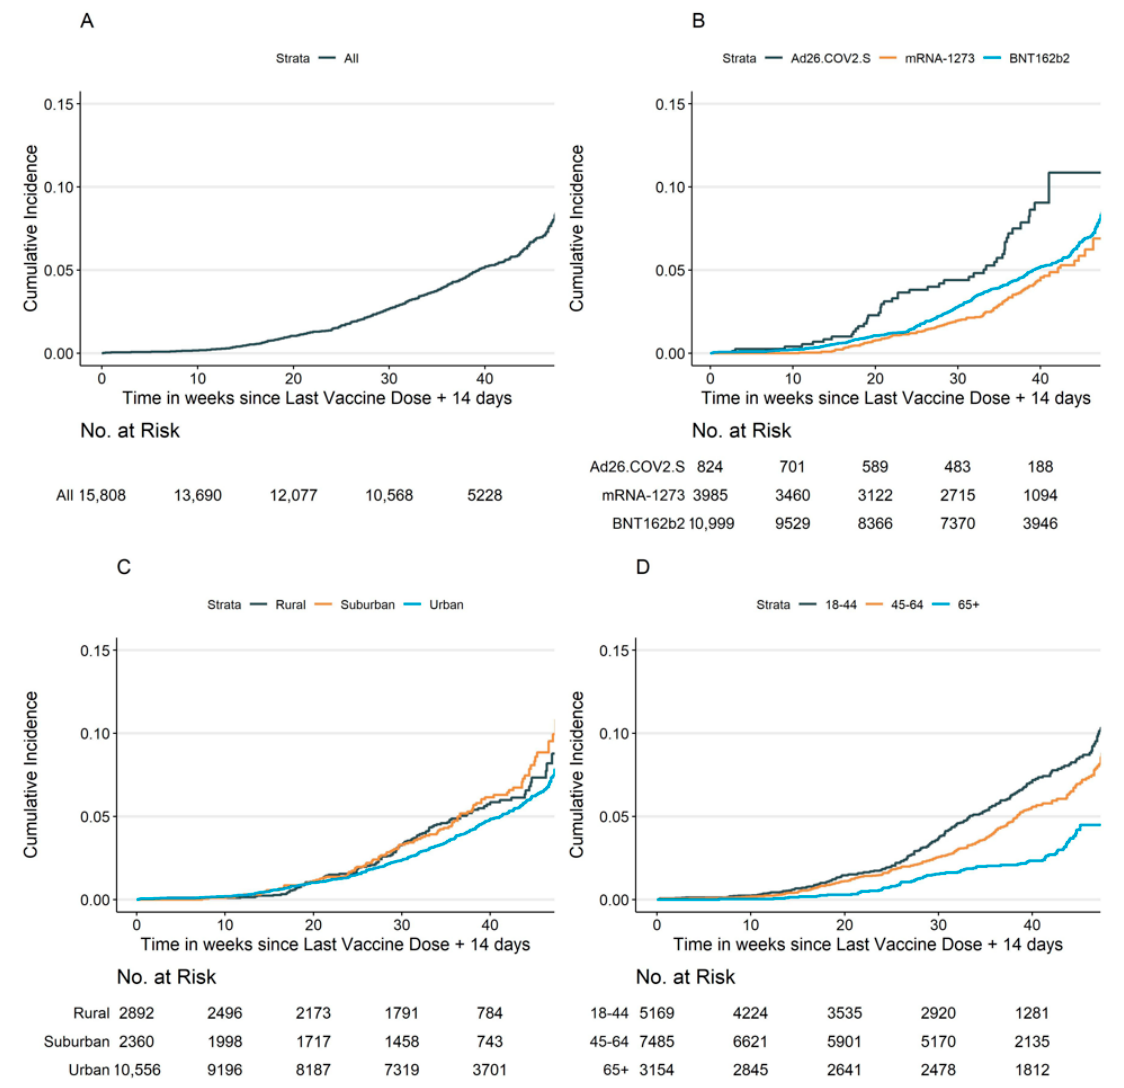
Figure 1. Cumulative incidence curves of breakthrough infection among participants who reported full vaccination (1 minus the unadjusted Kaplan – Meier risk). Below each graph is the number at risk at each time point for the first self-reported symptomatic positive SARS-CoV-2 test, starting from full vaccination: ( A ) Overall; ( B ) By vaccine product; ( C ) By county classification; ( D ) By age stratum.